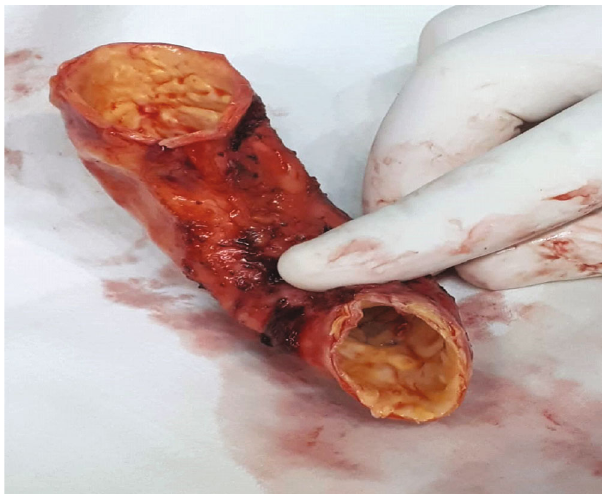
Figure 2: The intima develops wrinkle ridges and plaques described as a “ tree bark appearance.